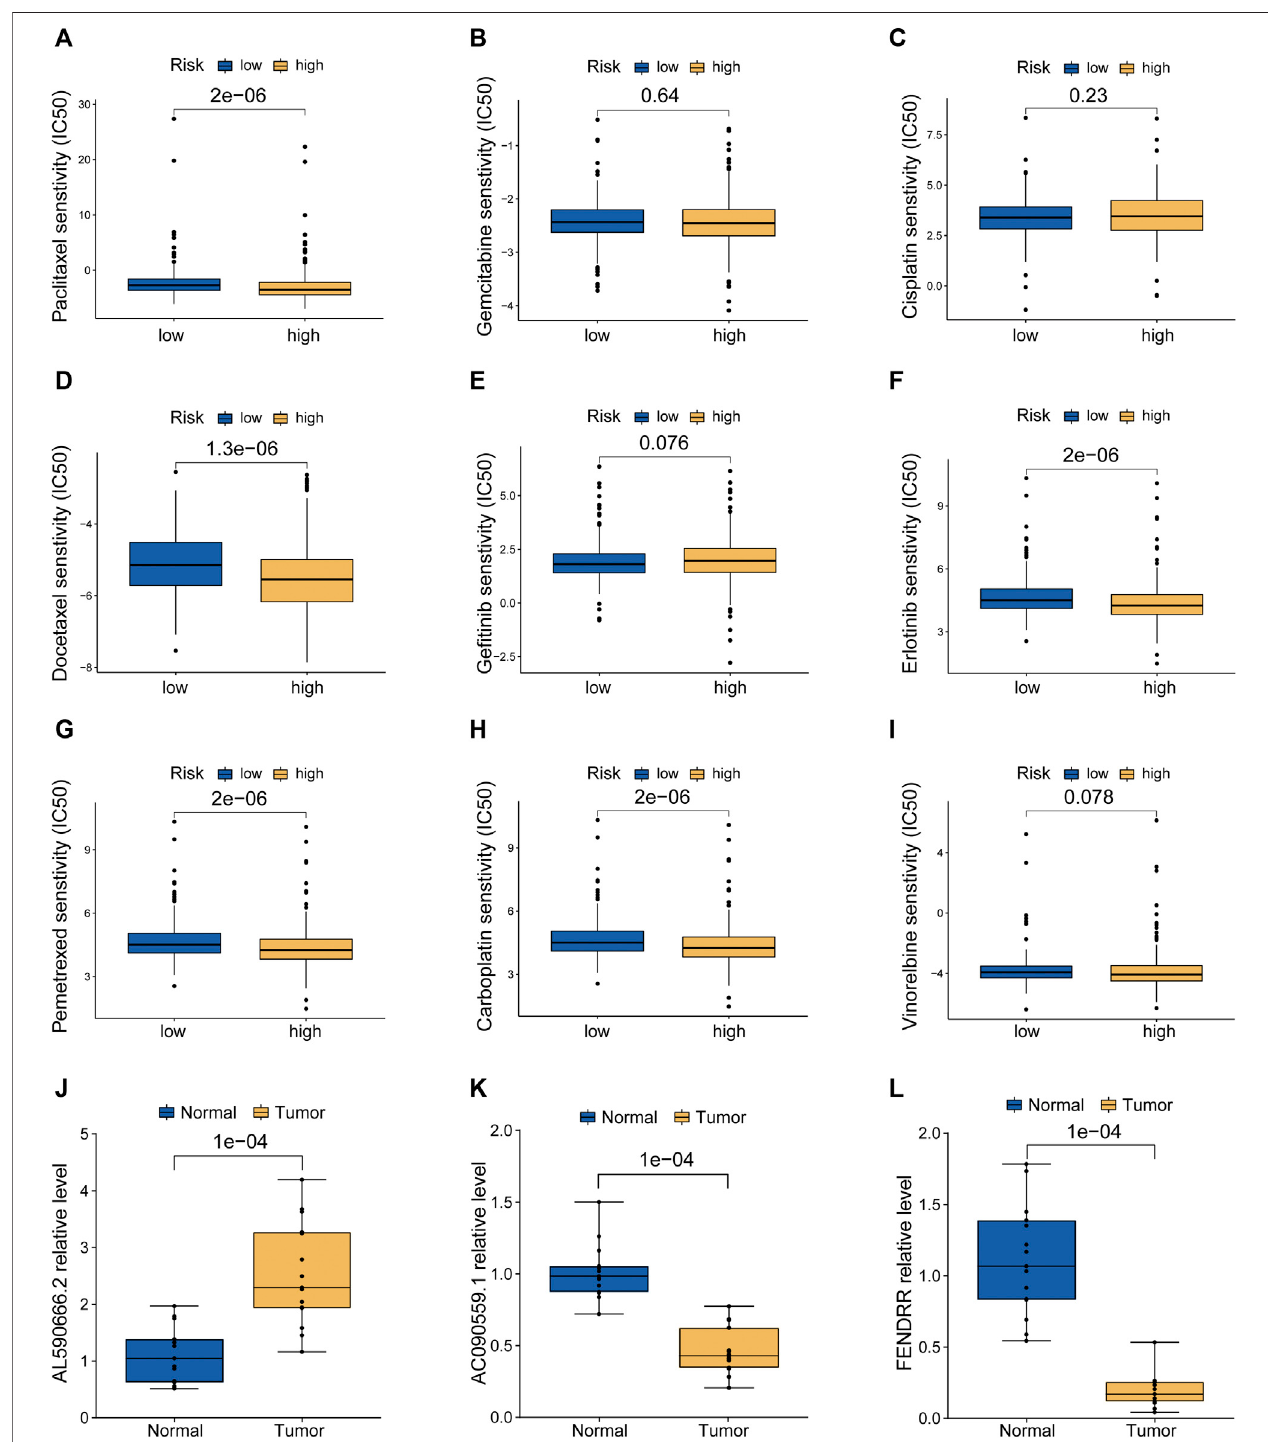
FIGURE 7 | Screening of candidate compounds and model validation in human LUAD specimens. (A – I) Sensitivity analysis of nine chemotherapeutic and molecular-targeted agents in the low- and high-risk patients. (J – L) Validation of the expression differences of three risk MHRlncRNAs in human LUAD tissues and adjacent normal